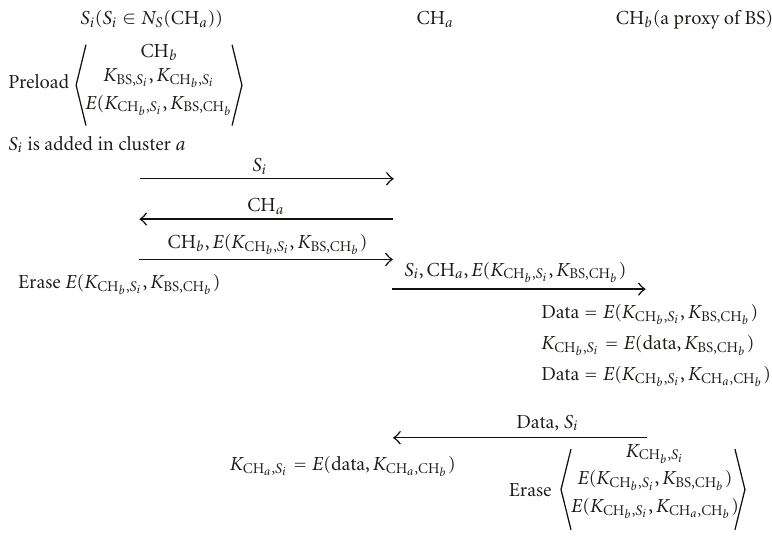
Figure 4: Protocol illustration of adding a new sensor node when BS is o ff